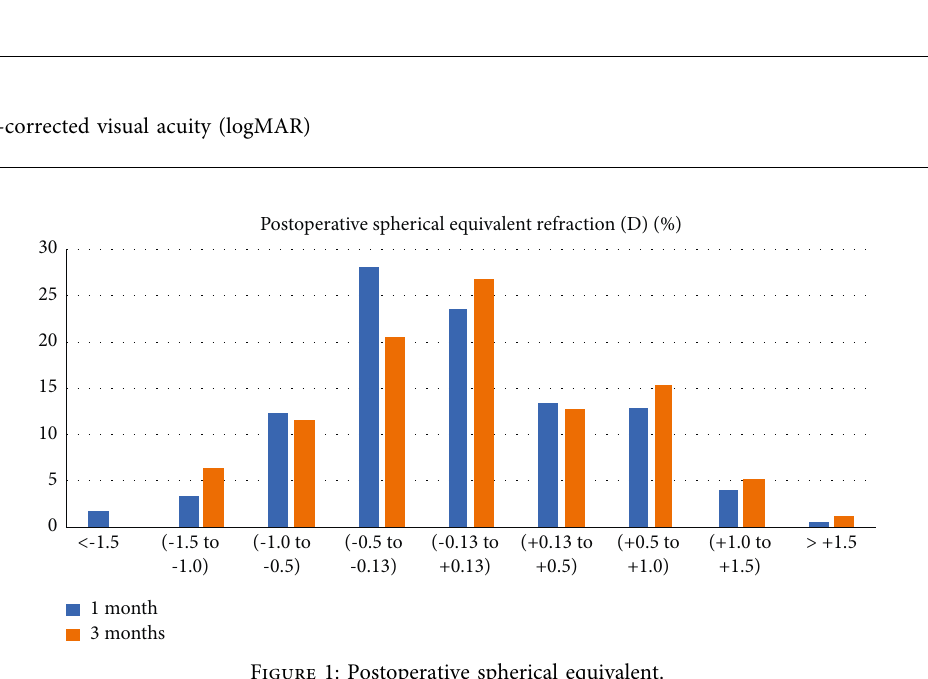
Figure 1: Postoperative spherical equivalent.